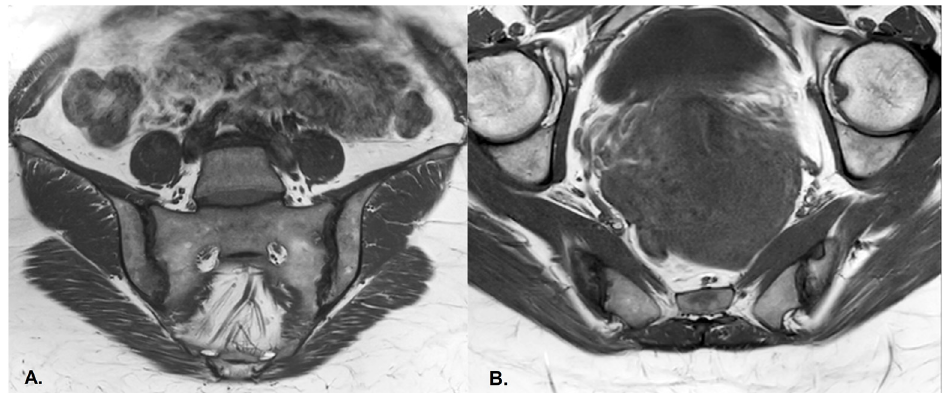
Figure 5. ( A ) Coronal and ( B ) axial T1-weighted sequences of the sacroiliac joints demonstrate subchondral sclerosis and erosions, predominantly on the right side, in the same patient as in Figure 4, consistent with sacroiliitis grade III.